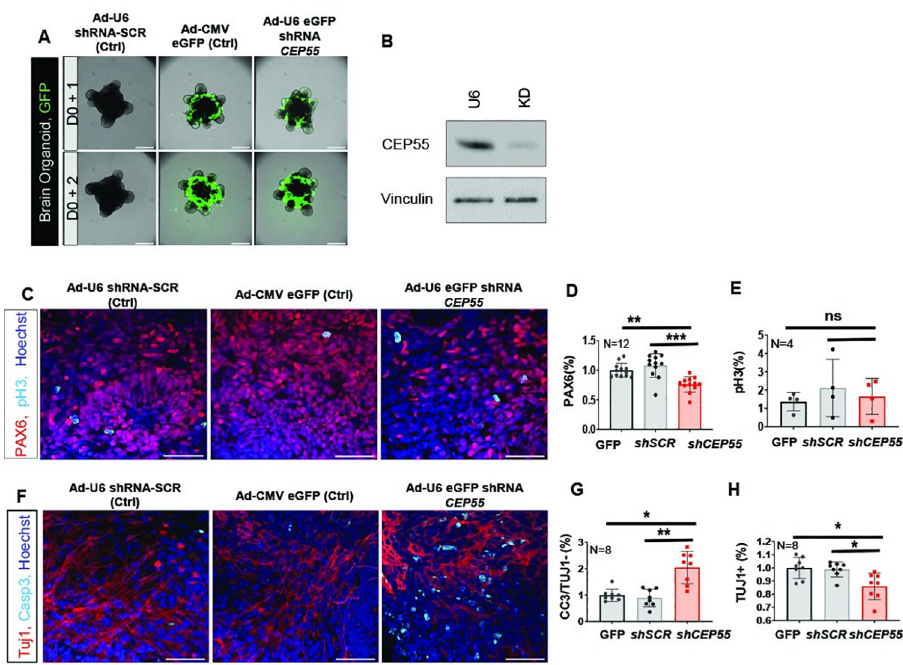
Fig 3. CEP55 knockdown induces cell death in neural progenitors of human cerebral organoid. (A) Day 16 of human iPSC-derived cerebral brain organoids infected with U6 scrambled control (left), CMV GFP control (middle) and CEP55 knockdown (KD) (right) adenoviral shRNAs with GFP-tag. Expression levels of integrated viral GFP increased significantly between days 1 to 2 post-infection at a MOI of 10. shRNA U6 scrambled control did not contain a GFP tag. Upper panel: D0 (infection day) +1; lower panel: D0 +2, scale bars = 50 μ m, immunofluorescent labeling of cerebral organoids was done after 24 hours of shRNA infection. The brain organoid differentiations were repeated as 3 entirely separate differentiations, each containing 192 technical replicates towards all the described experiments. Each technical organoid replicate was also cultured independently for the described 18 days post induction. (B) Immunoblot shows knockdown of CEP55 in adenoviral shRNA against CEP55 transduced organoid compare to U6 scrambled control. Vinculin serves as the loading control. (C) Representative images of labeling for neural progenitor PAX6, mitotic marker pH3 and nuclear Hoechst showed a decrease in neural progenitor PAX6 in the CEP55 KD shRNA infected organoids compared to the U6 and GFP controls. (D-E) Quantified immunolabelled organoids (normalized to CMV GFP control) for (D) PAX6, p < 0.0045 (GFP) and, P < 0.0001 (shSCR) and (E) pHH3, p > 0.9804 (GFP) and, P > 0.999 (shSCR). (F) Representative images of labeling for neural-specific tubulin TUJ1, apoptotic marker cleaved caspase 3, and nuclear Hoechst showed a clear increase in cell death in the CEP55 KD samples compared to the controls. (G-H) Quantified immunolabelled organoids (normalized to CMV GFP control) for (G) Cleaved Caspase-3 in non Tuj1+ cells, p < 0.0100 (GFP) and P < 0.0027(shSCR); TUJ1/Caspase3 double positive cells by first identifying a TUJ1+ cell by the presence of a positively stained nucleus (Hoechst staining) and subsequently counting whether they were double positive for Caspase3, (H) Total Tuj1+ cells, p < 0.0157 (GFP) and p < 0.0362 (shSCR). For all calculations, data represented mean ± SD, the number of organoids indicated in figures. One-way ANOVA (Kruskal–Wallis test) performed; � p < 0.05, �� p < 0.01, scale = 50 μ